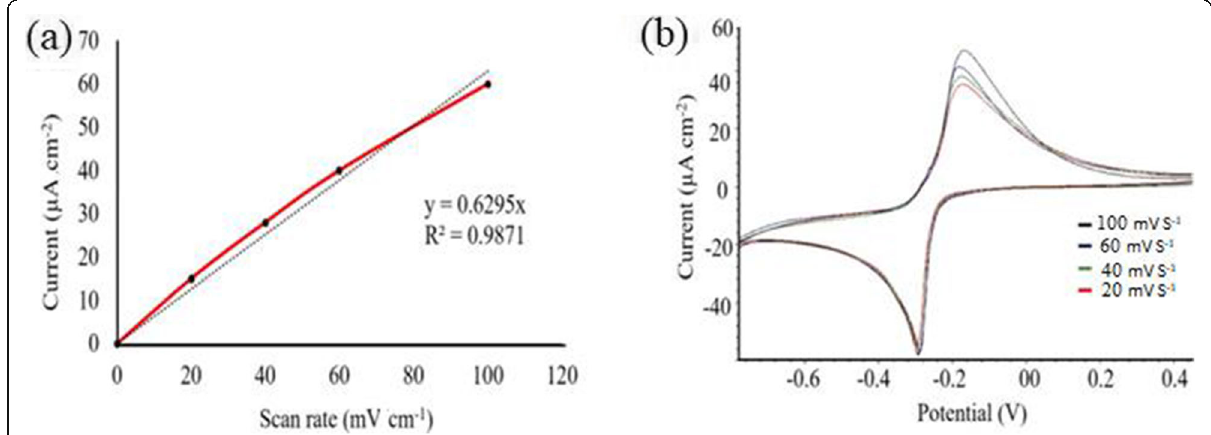
Fig. 6 ( a ) Linear plot between scan rate vs. cathodic current ( b ) Cyclic voltammogram of CuO